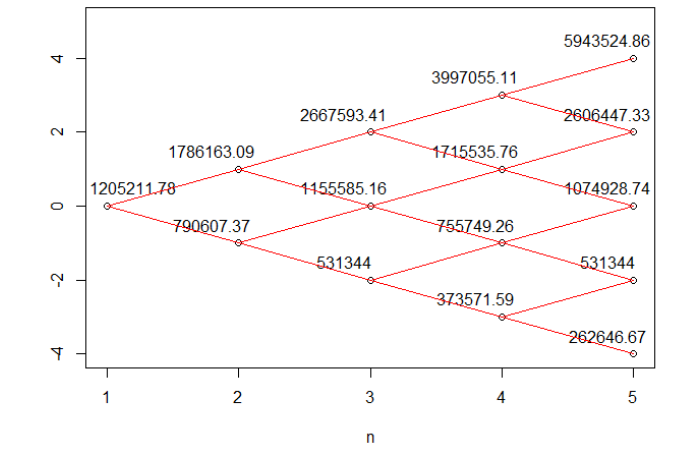
Figure 2. Tree 2 option to